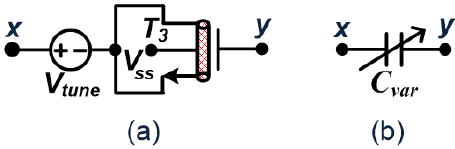
Figure 8. CNFET based varactor: ( a ) Transistor-level realization; ( b )